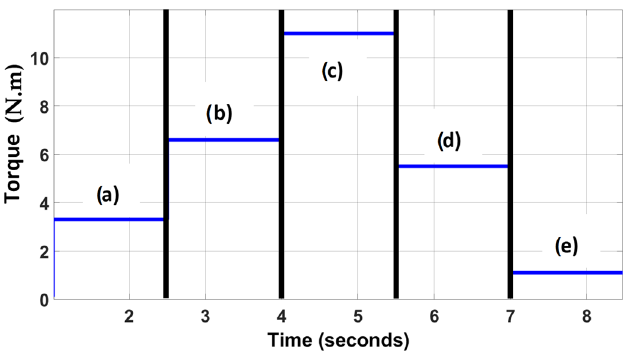
Figure 3. Torque variation steps: (a) 30% of rated torque; (b) 60% of rated torque; (c) at full load; (d) 50% of rated torque; and (e) 10% of rated torque.